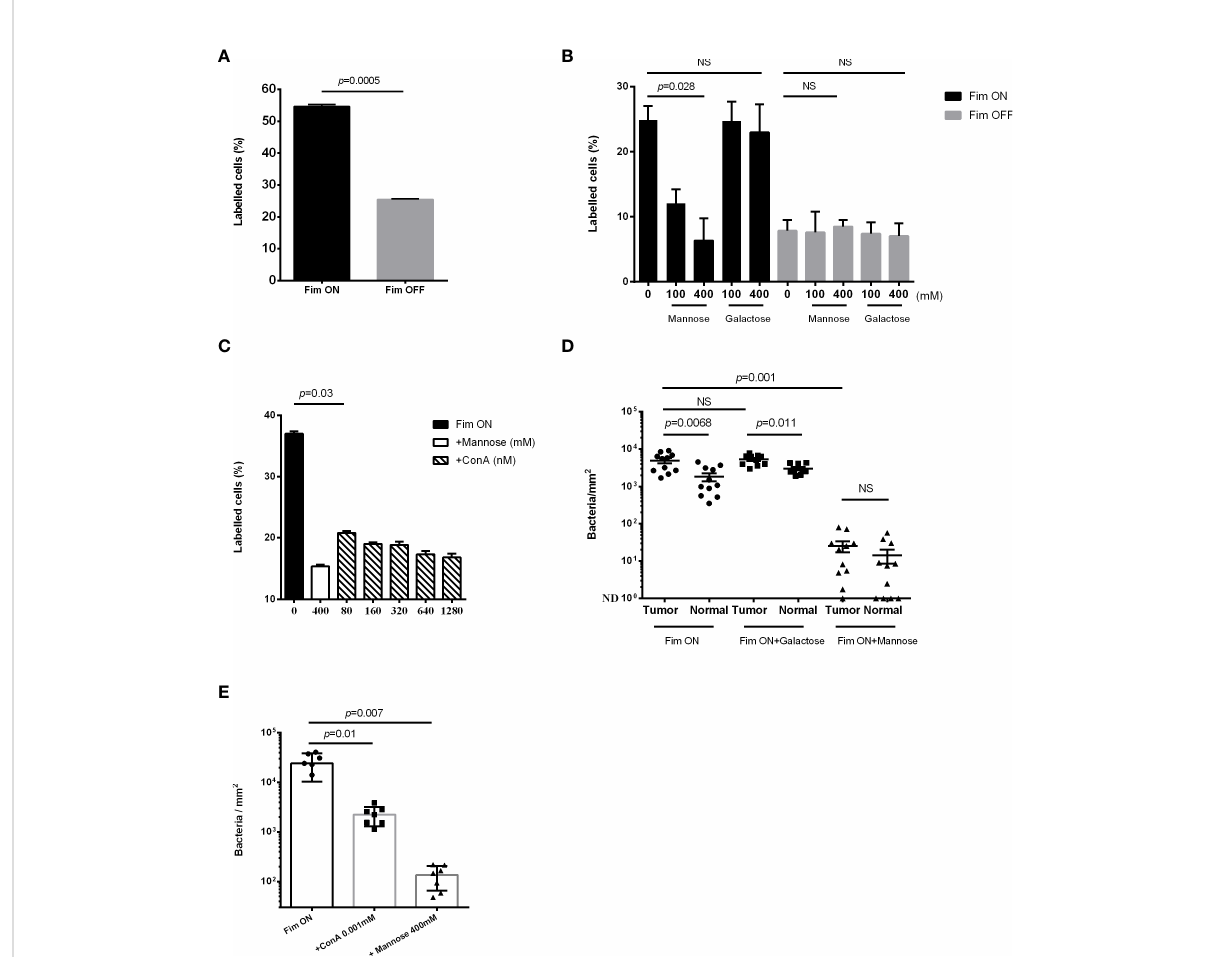
FIGURE 2 High mannose levels increase type 1 fi mbria mediated, UPEC attachment to bladder cancer. (A, B, C) Flow cytometry analysis of GFP-expressing UPEC Fim ON or Fim OFF attachment to mouse bladder cancer cell lines MBT2 (A) , and MB49 (B, C) , in the absence (A) or presence (B, C) of the competing agents mannose, galactose, or ConA at the indicated concentrations. Data represents mean ± SEM of three independent experiments performed in triplicate in A and B, and fi ve independent experiments performed in triplicate in C, NS, non-signi fi cant. p was calculated using two-tailed paired t-test (ratios between paired values) in A, Bonferroni corrected two-tailed paired t-test (differences between paired values) in B, and one-tailed Wilcoxon matched-pairs signed rank test in C. (D, E) Fluorescence microscopy analysis of the attachment of GFP-expressing Fim ON to bladder cancer samples (Tumor) and normal adjacent tissue (Normal) (BL244 tissue microarray) (D) , and to bladder cancer samples (T124a tissue microarray) (E) , in the absence or presence of 400 mM mannose, 400 mM galactose or 0.001 mM ConA. Quantitation of bacteria was performed as described in materials and methods and then divided by ROI areas. NS, non-signi fi cant (p>0.05). Each symbol represents one core. Means are shown with SD. p was calculated using Bonferroni corrected two-tailed Wilcoxon matched-pairs signed rank test in (D) , and Bonferroni corrected one-tailed Wilcoxon matched-pairs signed rank test in (E)